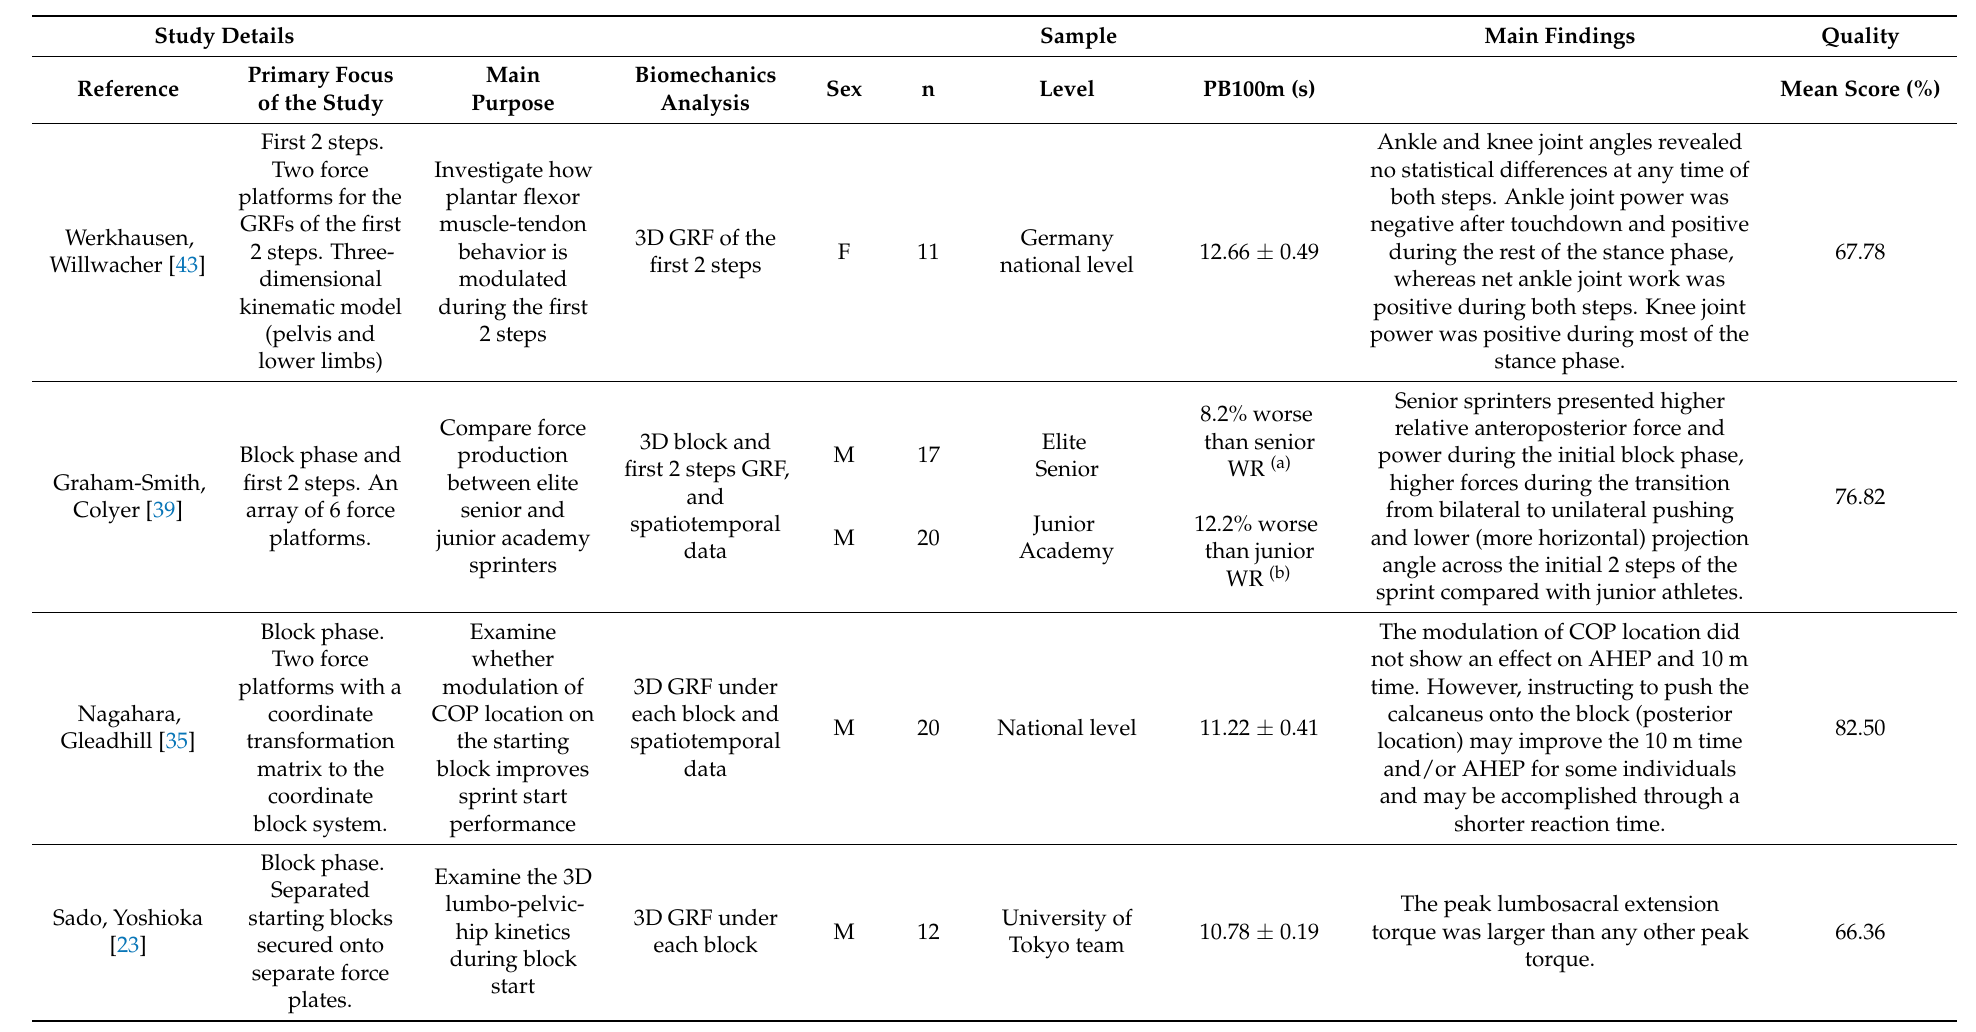
Table 1. Studies are listed in reverse-chronological order by year, followed by alphabetically for studies published in the same year. Samples (n) are restricted to total participating sprinters and are classified by performance level(s) according to the original